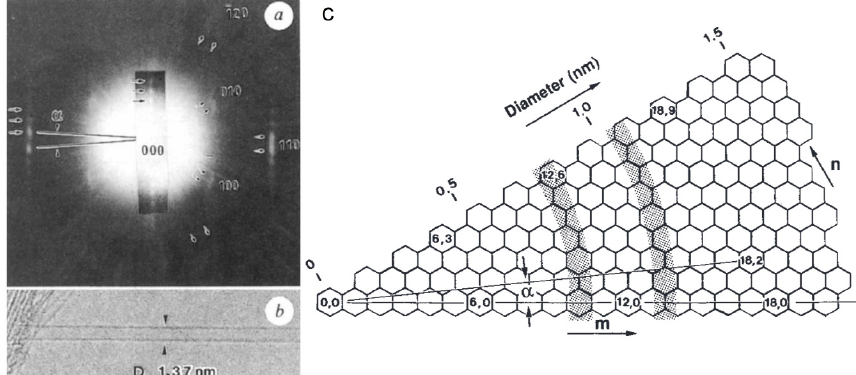
Figure 29. ( a ) ED pattern taken from a single-walled carbon nanotube (SWCNT) of diameter 1.37 nm. ( b ) Electron micrograph of the same SWCNT. The pattern comprises two sets of hexagonal patterns which give rise to splitting of the ( hk 0) spots. Each spot has periodic intensity maxima in the vertical direction, caused by Frauenhofer diffraction from the two portions of tube imaged as dark line in ( b ). ( c ) Schematic representation of helical tubules according to Hamada’s representation. A tubule is represented by an index ( m , n ) or ( m , α ), where m is the m -th hexagon from the origin (0,0), n and chiral angle α are defined as shown. Reproduced with permission from Iijima and Ichihashi [101]. Copyright Springer Nature,